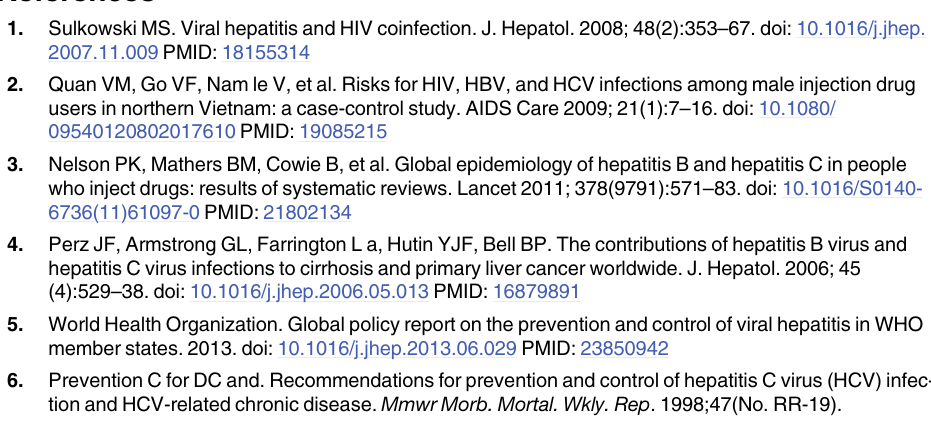
S1 Table. HIV, Viral Hepatitis, and Co-infection prevalence by province.